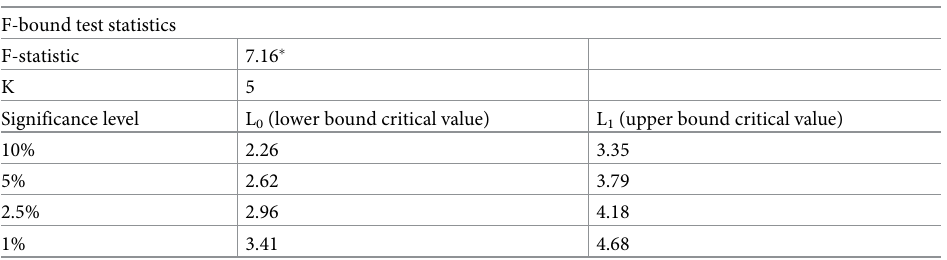
Table 6. F-bound test results.